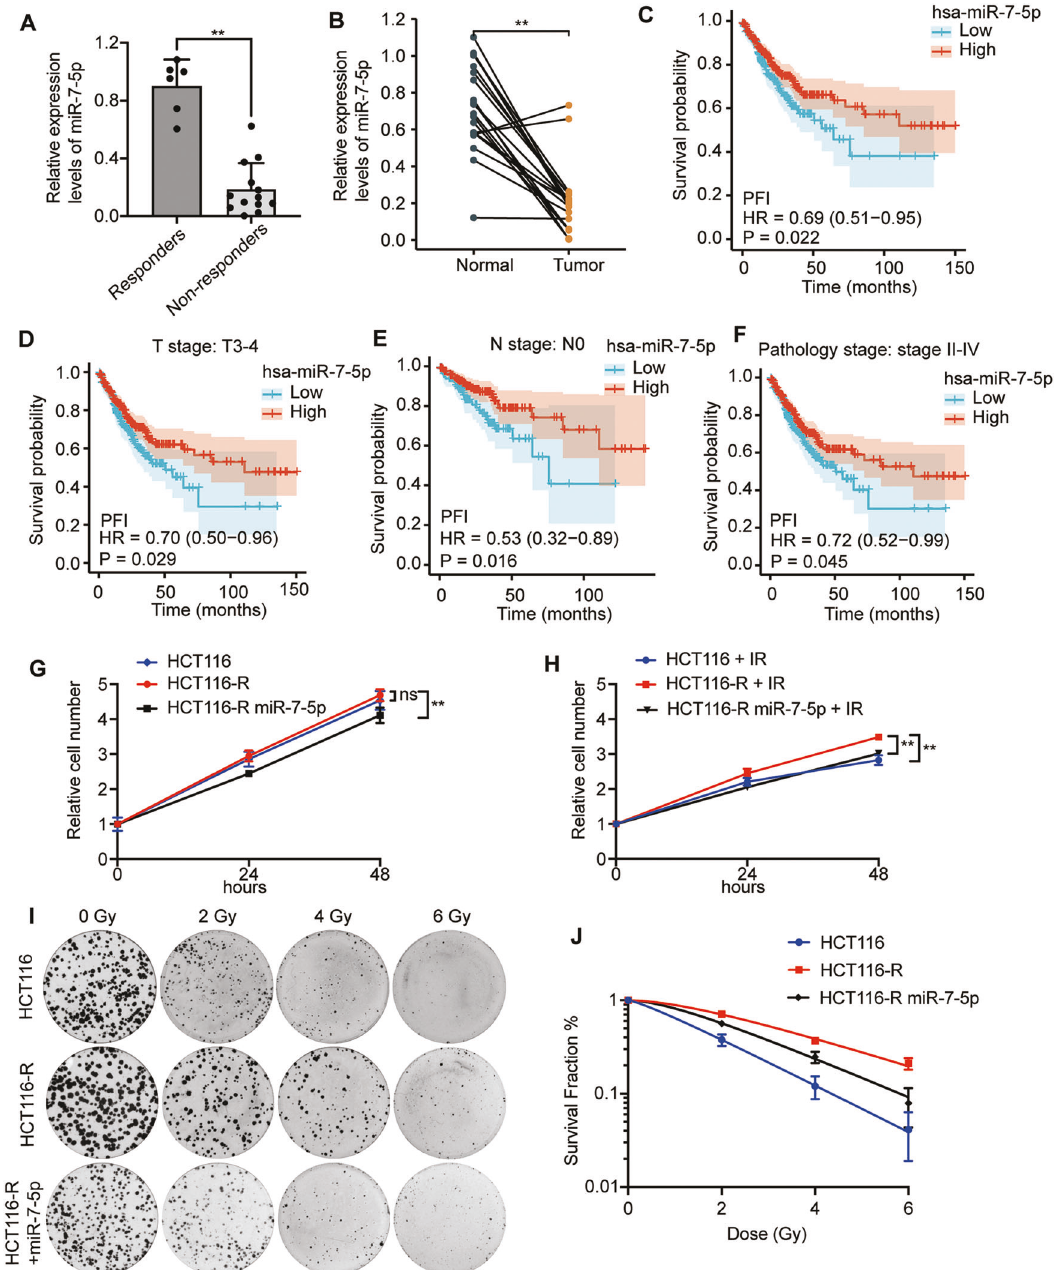
Fig. 1 The correlation between the miR-7-5p level and response to radiotherapy in CRC cells. A QRT-PCR analysis of miR-7-5p expression in radiosensitive (responders) and radioresistant (non-responders) rectal cancer tumor tissues. B QRT-PCR analysis of miR-7-5p expression in CRC tumor tissues and corresponding adjacent normal tissues from 20 CRC patients. Analysis of RNA-seq data retrieved from TCGA-COADREAD illustrated that low expression of miR-7-5p was correlated with shorter progression-free intervals (PFI) (C) , and the subsequent subgroup analysis showed that those CRC patients with lower miR-7-5p expression at clinical T3-4 stage ( D ), N0 stage (E) or Pathology stage II-IV (F) had shorter PFI. G , H Cell proliferation assays in HCT116, HCT116-R and miR-7-5p-overexpressing HCT116-R cells w/wo 4 Gy irradiation treatment. I Representative images of colony formation assays in HCT116, HCT116-R and miR-7-5p-overexpressing HCT116-R cells treated with various doses of irradiation (0, 2, 4, and 6 Gy). J The survival analysis in HCT116, HCT116-R and miR-7-5p-overexpressing HCT116-R cells treated with 0, 2, 4 or 6 Gy irradiation, respectively. Data are presented as mean ± SD; qRT-PCR, quantitative real-time PCR; w/wo, with or without; IR irradiation, ns no signi fi cant difference; ** P < from 4.03 ± 0.75% to 2.67 ± 0.06% without irradiation, and [15, 29]. Sphere formation assays were performed identifying reducing from 9.10 ± 2.34% to 5.10 ± 0.50% with 4 Gy irradiation that overexpressing miR-7-5p inhibited the CRC cell stemness by in HCT116-R following miR-7-5p overexpression. Moreover, to decreasing both sphere number and sphere size w/wo 4 Gy clarify the underlying mechanisms governing the regulation of irradiation (Fig. 3A, B). The changes of the CD133 + CSC CSC by miR-7-5p in CRC cells, a group of stemness-related subpopulation were further detected by fl ow cytometry analysis proteins were detected by western blot assay, illustrating that (Fig. 3C, D), indicating the proportion of CD133 + cells decreasing